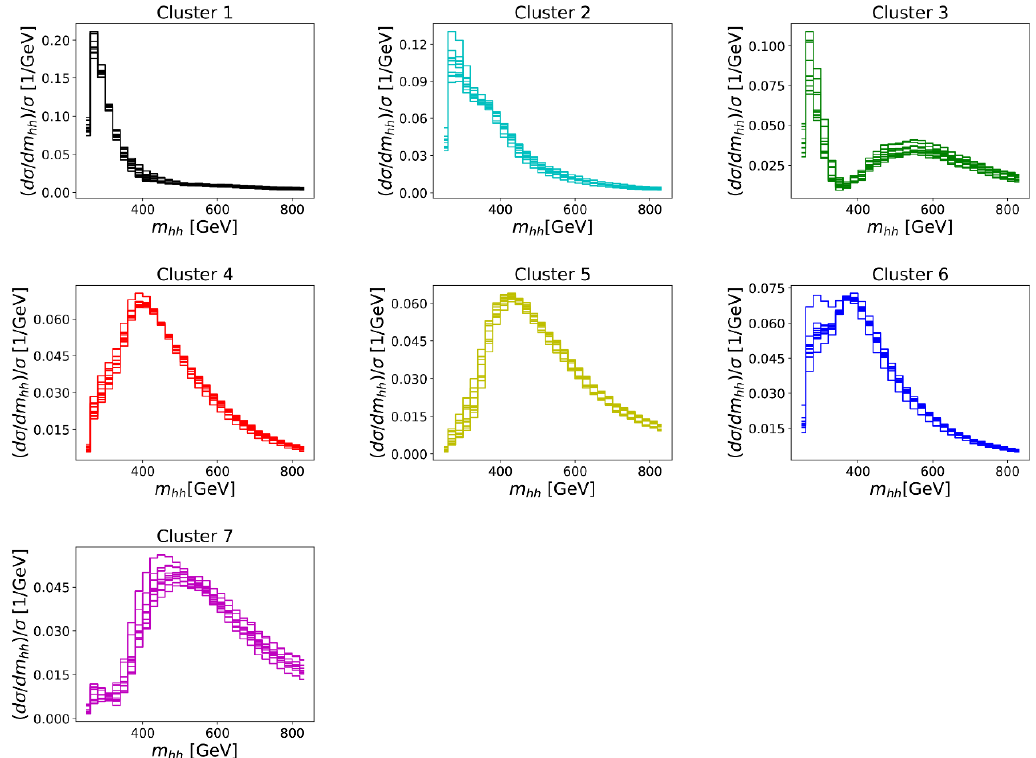
Figure 10 . The clusters obtained by asking for a classi(cid:12)cation into seven shape types. The cluster centres obtained from 10 di(cid:11)erent encoder models are shown in the colour code de(cid:12)ned in table 1.